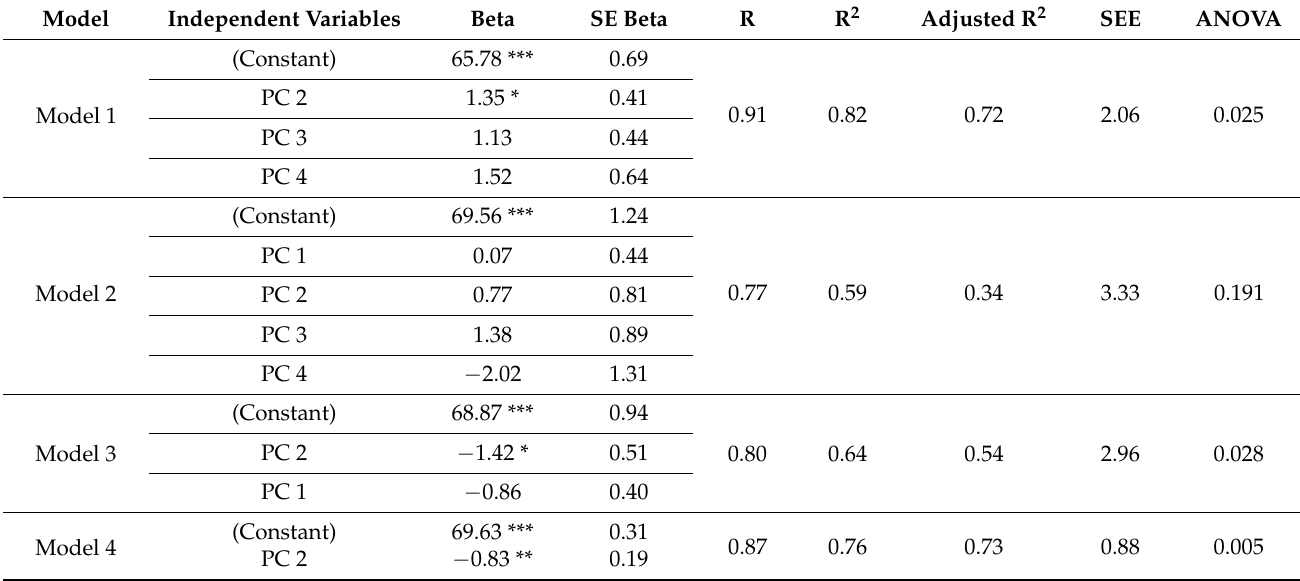
Table 5. Final models after forwarding stepwise multivariate regression analysis for dependent variable VO 2 max on each training period from 1 to